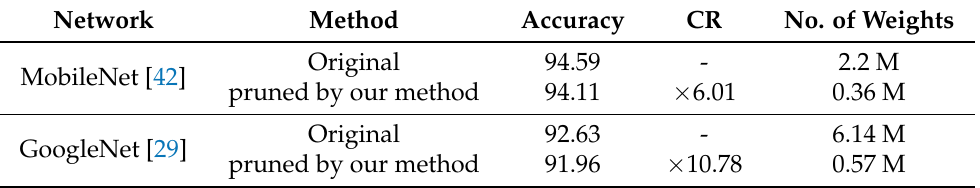
Table 3. The results by applying our method to MobileNetV2 and GoogleNet (CIFAR10